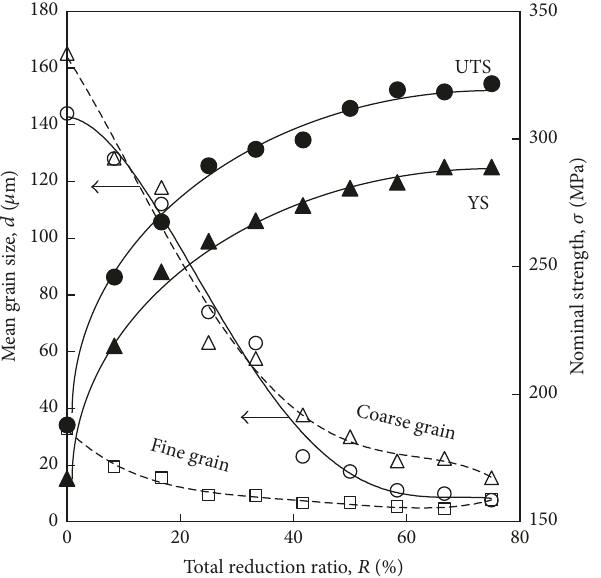
Figure 2: Effect of the total reduction ratio on the strength (yield strength (YS) and ultimate tensile strength (UTS)) and mean grain size of the test specimen. The mean grain sizes of the fine and coarse grain regions are shown.